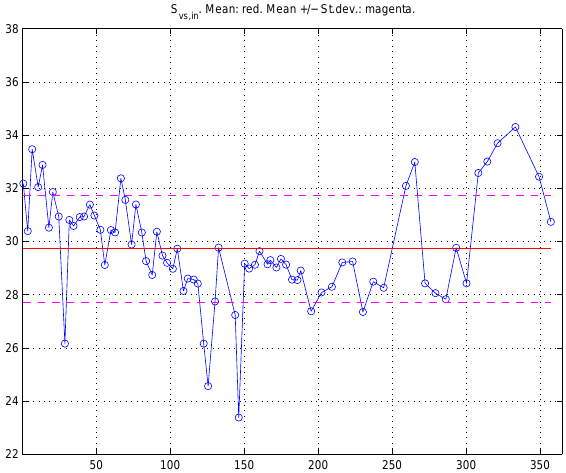
Figure 2: Plot of S vs from laboratory analysis over in one year. Mean value: µ S = 29 . 7 g/L. vsin Standard deviation: σ S = 2 . 0 vs in